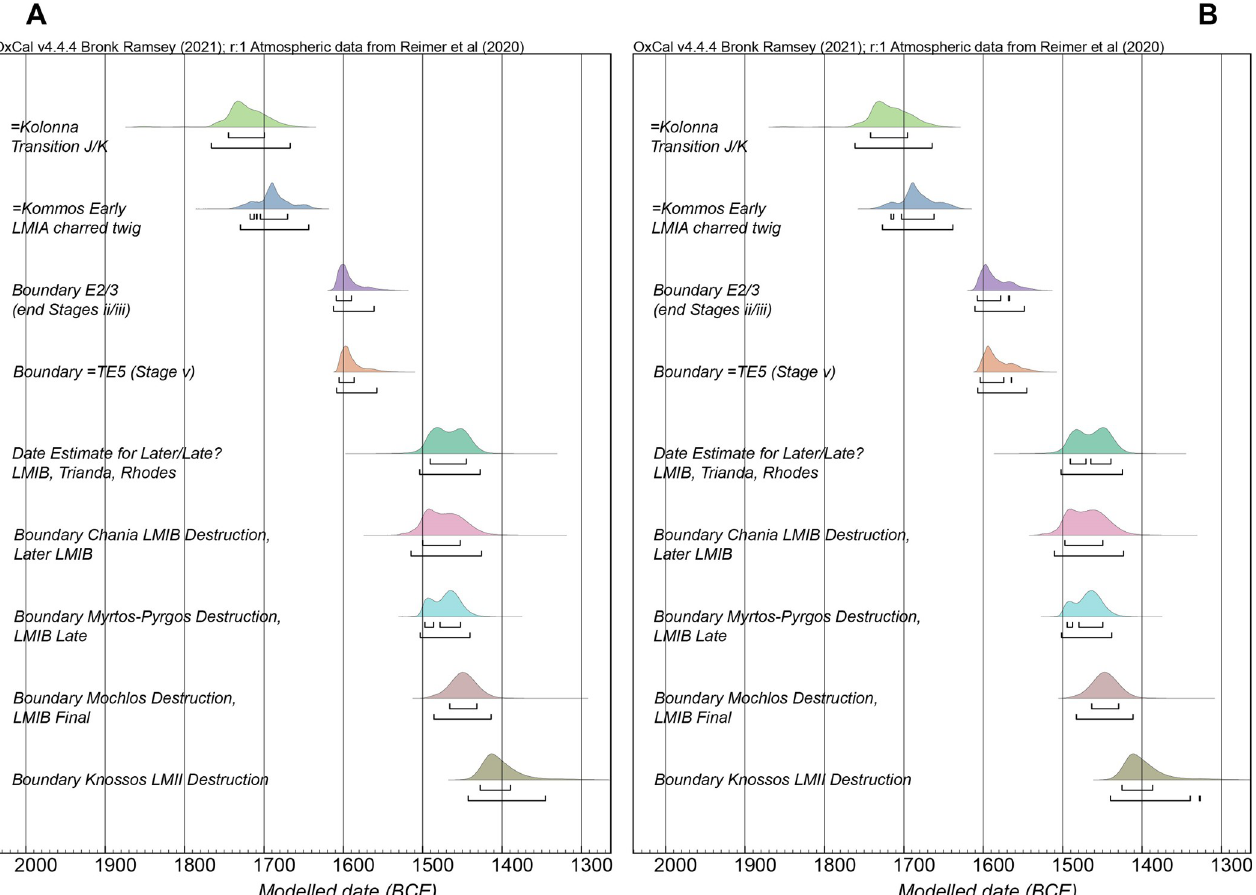
Fig 12. Dating results for the main elements of Model 2 integrating datasets (i), (j), (l) and (m) with Model 1 (as used for Fig 9) (datasets (a)-(c)) to give a temporal sequence running from end MBA/start LCI/LHI/LMIA through to the end of LMII. (A) Model 2 with no GSRO. (B) Model 2 with the southern Aegean maximum GSRO test of 4 ± 2 14 C years. For the 68.3% and 95.4% hpd calendar age ranges indicated (upper and lower lines under each probability distribution, respectively), see Table 3. For results from re-runs of Model 2 without VERA-4630, see Table 4.